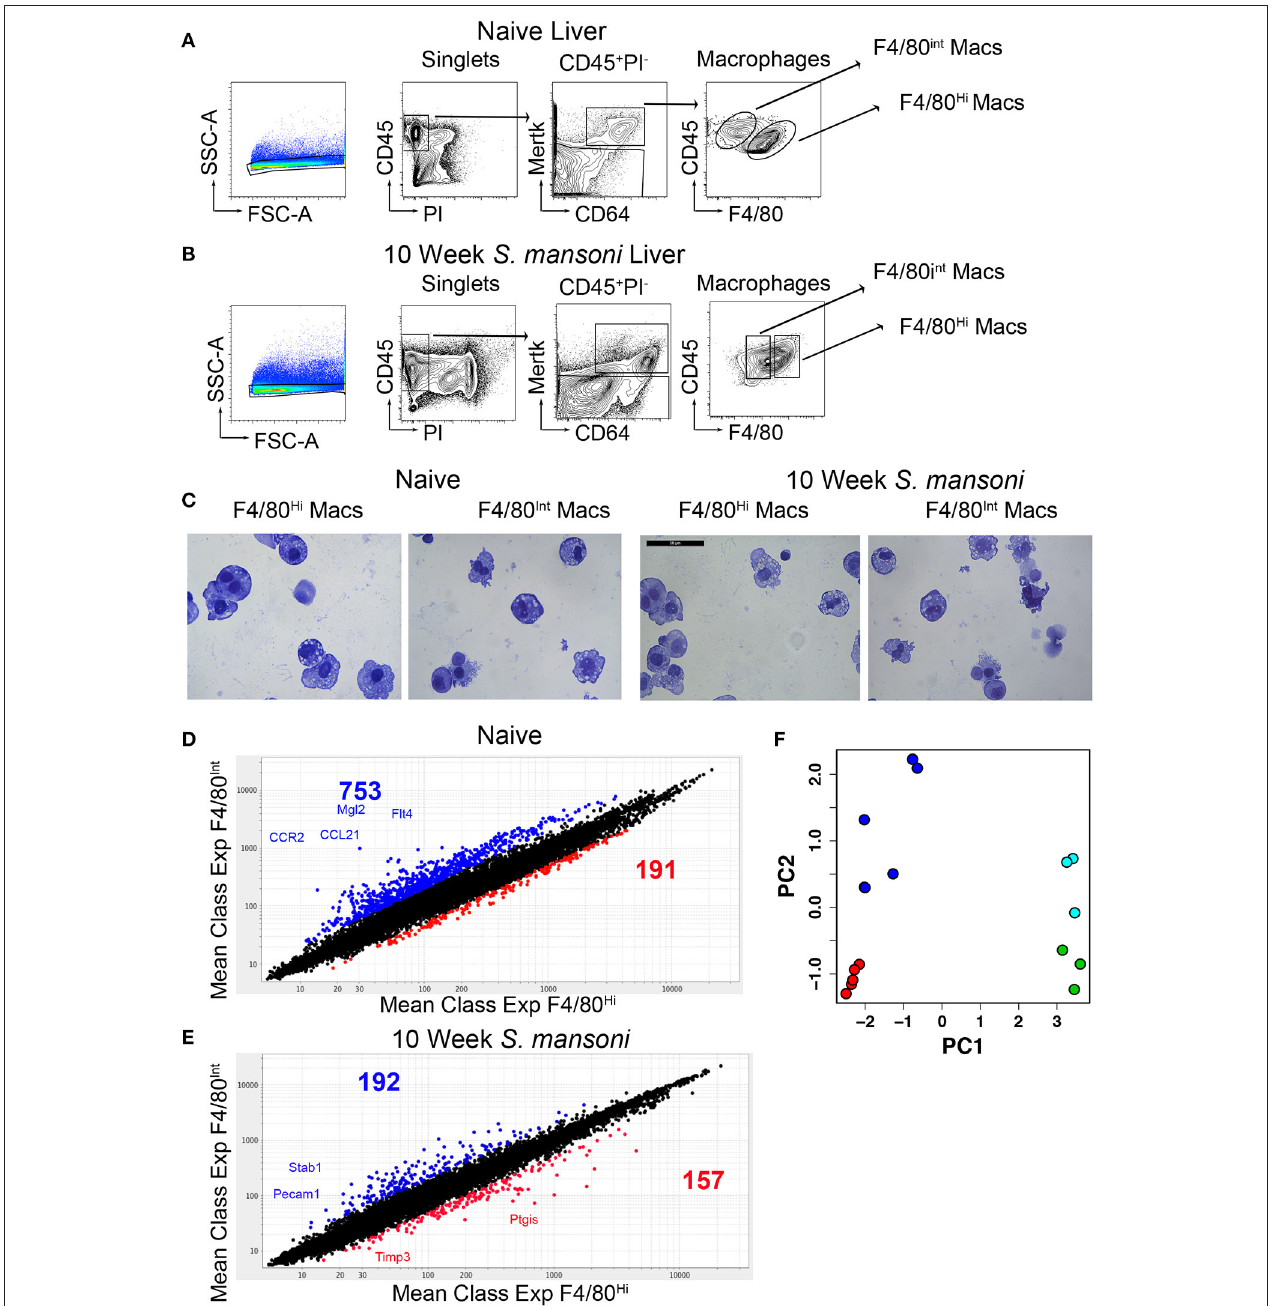
FIGURE 1 | Murine livers contain two distinct macrophage populations and S. mansoni infection decrease transcript diversity between Kupffer cells and perivascular macrophages. C57BL/6 male mice were either naïve or infected with S. mansoni for the indicated number of weeks. (A,B) Perfused livers were removed, digested with collagenase for 1h, and disrupted through a metal strainer to create single cell suspensions. Cells were identified by staining for the indicated markers and sorted on an Aria II. All populations were sorted two times, with the second sort going directly into Trizol according to the Immgen protocol. Individual animals were sorted from multiple litters/infections to achieve 4-5 biological replicates for individual microarray analysis. (C) Representative cytospins of aliquots from the second sorts of each macrophage populations were stained with H&E. (D,E) Total RNA was extracted, amplified, and transcript expression determined using whole-mouse genome Affymetrix Mouse Gene 2.0 ST Arrays through the Immunological genome consortium. (D) The number of probes increased by 2-fold with a p > 0.05 Blue indicates increased expression in F4/80 int liver macrophages at steady state, Red indicates increased expression in F4/80 hi liver macrophages at steady state. (E) The number of probes increased by 2-fold with a p > 0.05 Blue indicates increased expression in F4/80 int liver macrophages at steady state, Red indicates increased expression in F4/80 hi liver macrophages at 10-weeks post S. mansoni infection. Each group contained 3-5 individual RNA samples. (F) Principal component plot showing differences in gene expression profiles between samples of naïve F4/80 high cells (green), 10-week S. mansoni F4/80 high cells (red), naïve F4/80 int cells (cyan), and 10-week S. mansoni F4/80 int cells (blue).